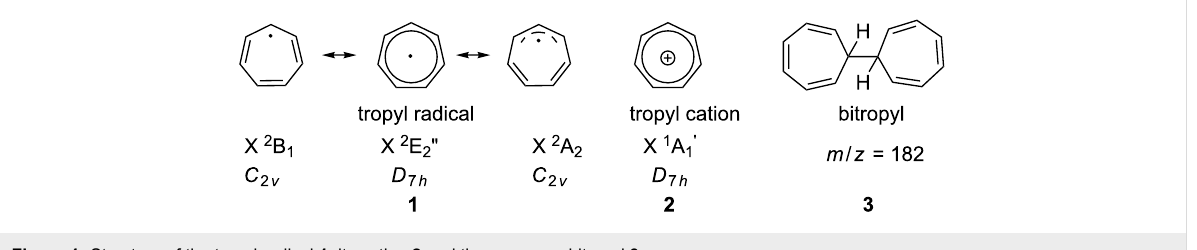
studied experimentally and theoretically. An early electron